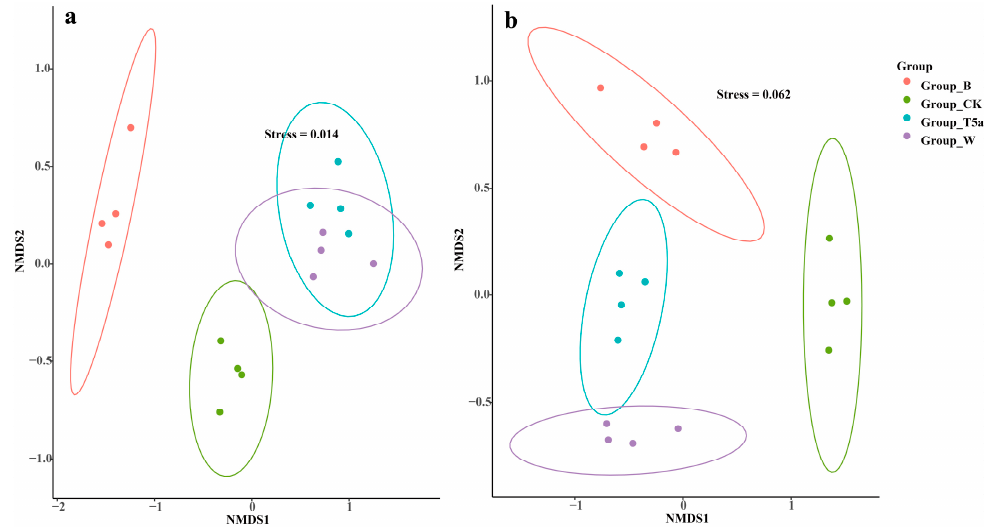
Figure 6. NMDS plots of bacterial ( a ) and fungal ( b ) communities in continuous cropping soil for G. leucocontextum cultivation. Note: The horizontal (NMDS1) and the vertical (NMDS2) are two sorting axes. Each point in the plot represents a sample. Each group was represented by one color. Similar samples are clustered together. A long distance between points means big difference between samples. The confidence ellipses are shown in the plot.